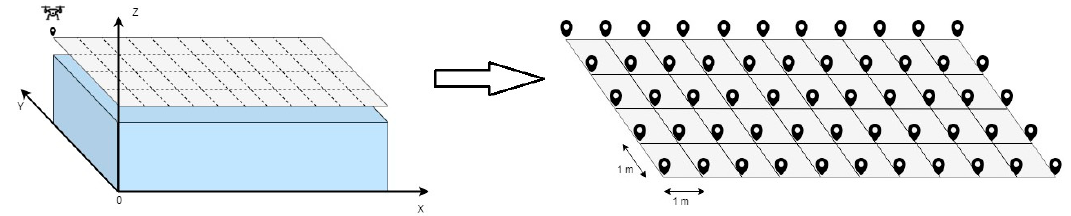
Figure 10. Rectangular grid of the measurement points.